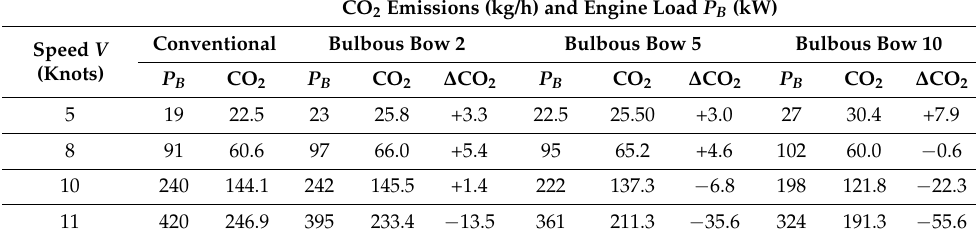
Table 8. CO 2 [kg/h] emissions and engine load P B (kW) at various vessel speeds for the analysed bulbous